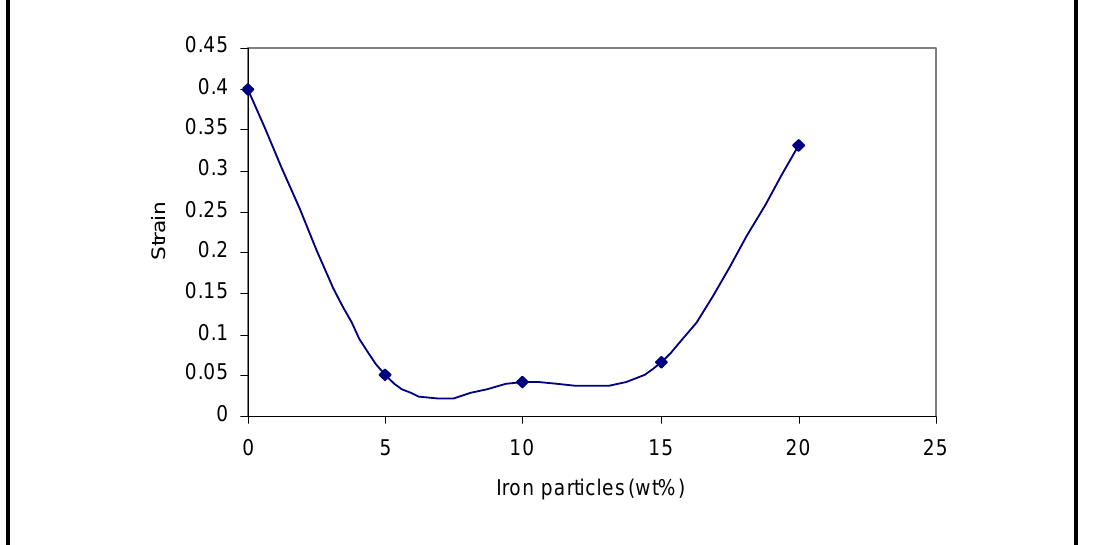
Fig. 4: Composite samples strain ( Δ L/L) as a function of Iron particles